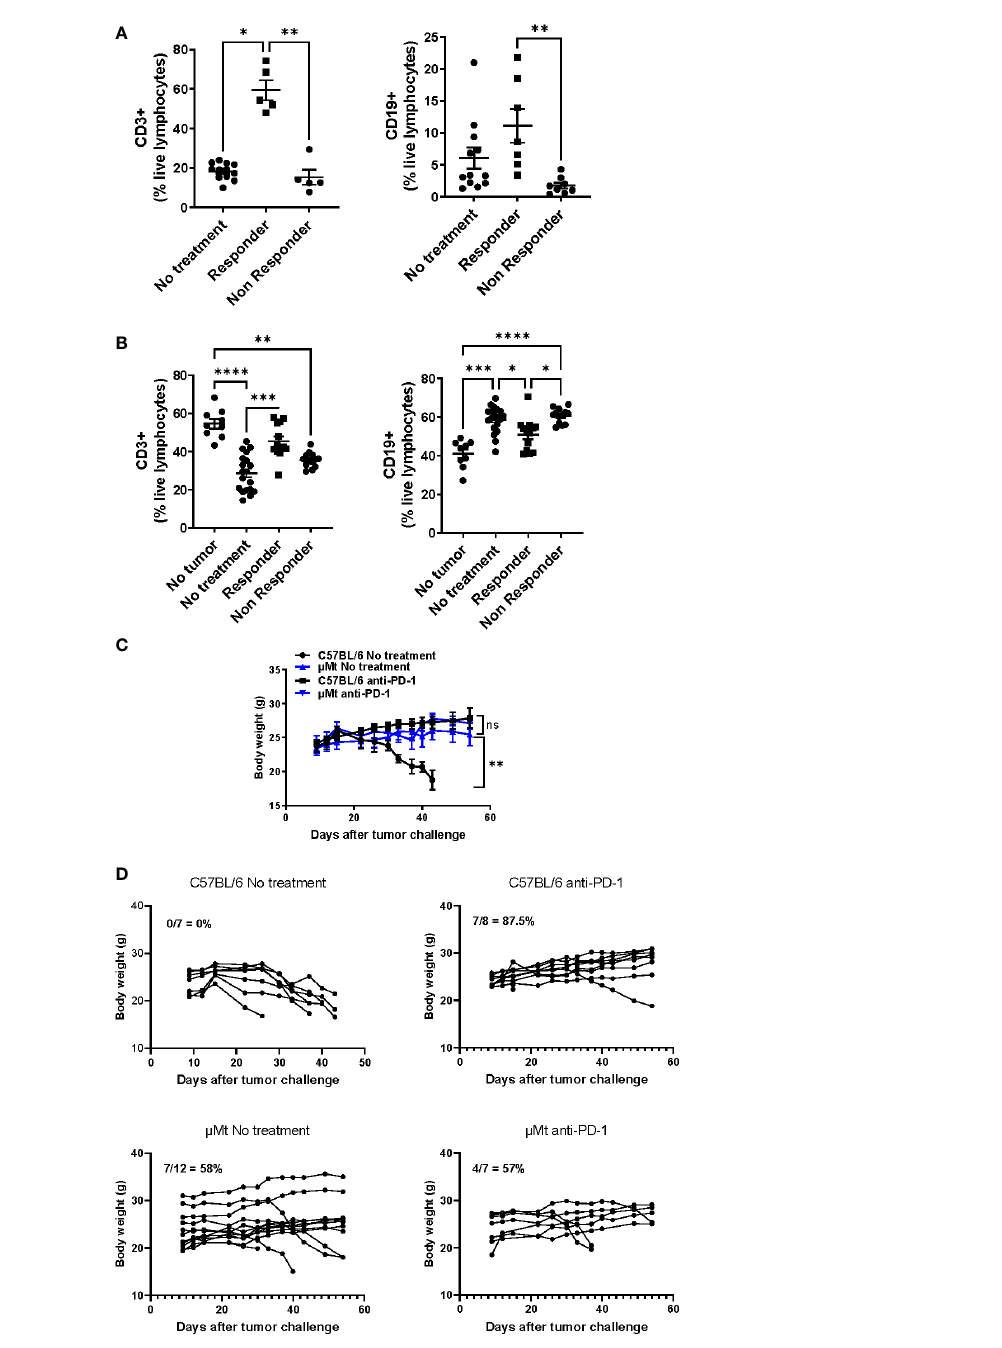
FIGURE 4 Differential in fi ltration of lymphocytes between PD-1 blockade responders and non-responders with HPV+ tongue tumors. C57BL/6 mice were injected in the tongue with (5 x 10 4 ) mEER tumor cells and then treated with anti-PD-1 at days 10, 13, and 16. After 30 days of tumor implantation, tongues were collected and mice were classi fi ed between responders (no visible tumor) and non-responders (visible tumor); a group of mice was left untreated. CD3+ T cells and CD19+ B cells were quanti fi ed in tumors (A) and tumor-draining lymph nodes (B) by fl ow cytometry (n = 5 – 19). The results shown are pooled data from 3 experiments. A Mann-Whitney test was performed *p< 0.05, **p < 0.005, ***p < 0.0005, ****p < 0.00005. A group of C57BL/6 and µMT mice were injected in the tongue with (5 x 10 4 ) mEER tumor cells and treated or not with anti-PD-1 on days 10, 13, and 16. Body weight was measured weekly between C57BL/6 and µMT mice treated or not with anti-PD-1. The average body weight ± SEM per group is depicted (n = 7 – 14 mice/group) (C) . The survival of mice was monitored over time and the percent survival per group is depicted (n = 7 – 12 mice/group) (D)